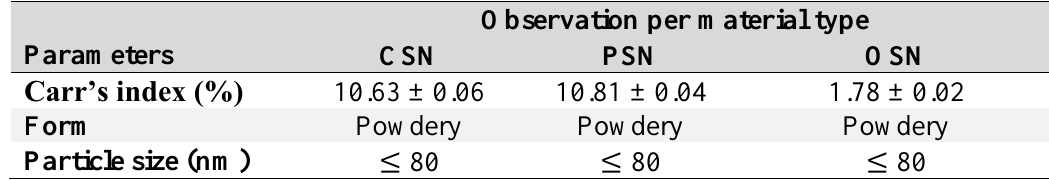
Table 1. Characteristic parameters of the ball-milled materials.